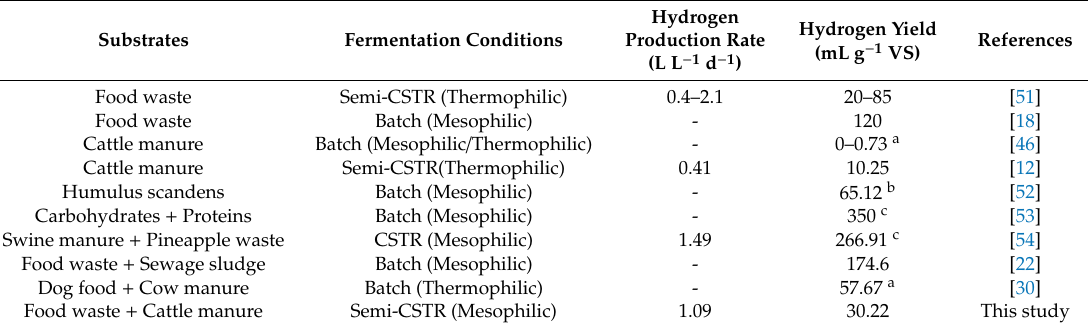
Table 7. Biohydrogen production by di ff erent